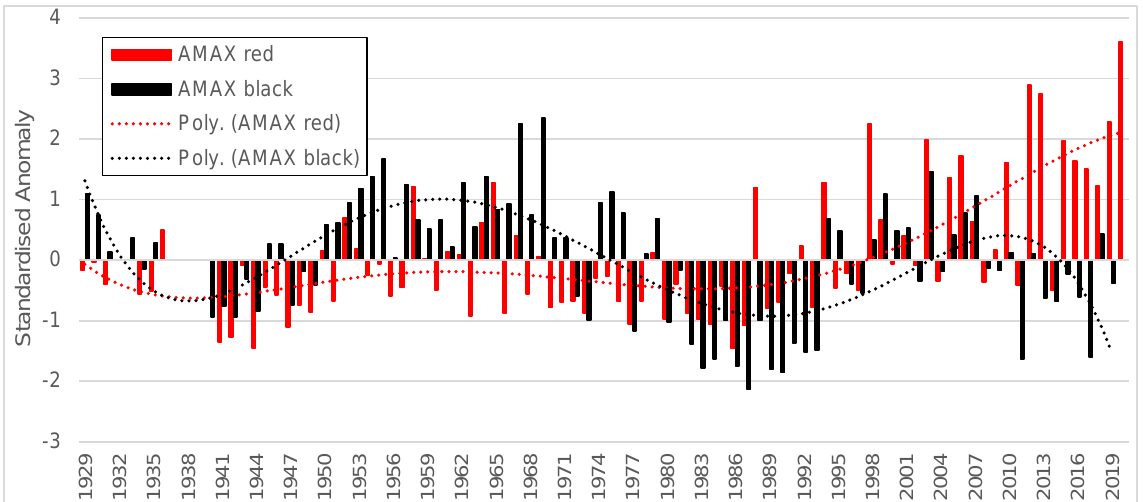
Figure 12. Anomalies of red and black flood at Niamey gauging station (1929–2020) and 5th degree polynomial interpretation.